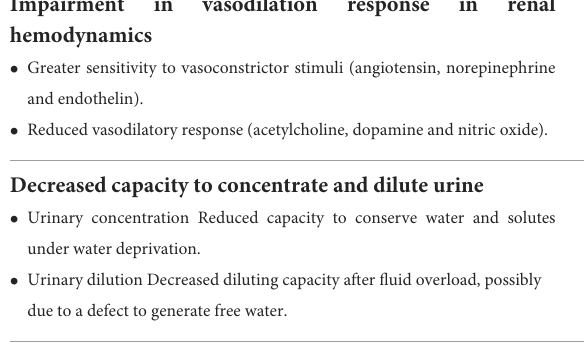
TABLE 2 Kidney functional changes with aging and declining GFR. Impairment in vasodilation response in renal